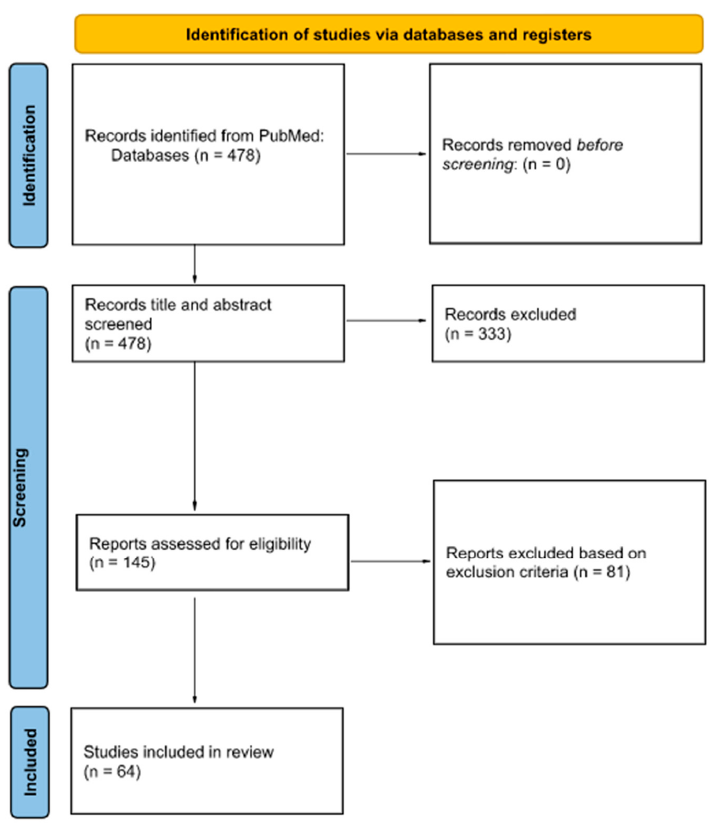
Figure 1. Flowchart for study selection in accordance with Preferred Reporting Items for Systematic reviews and Meta-Analyses extension for Scoping Reviews (PRISMA-ScR) guidelines.